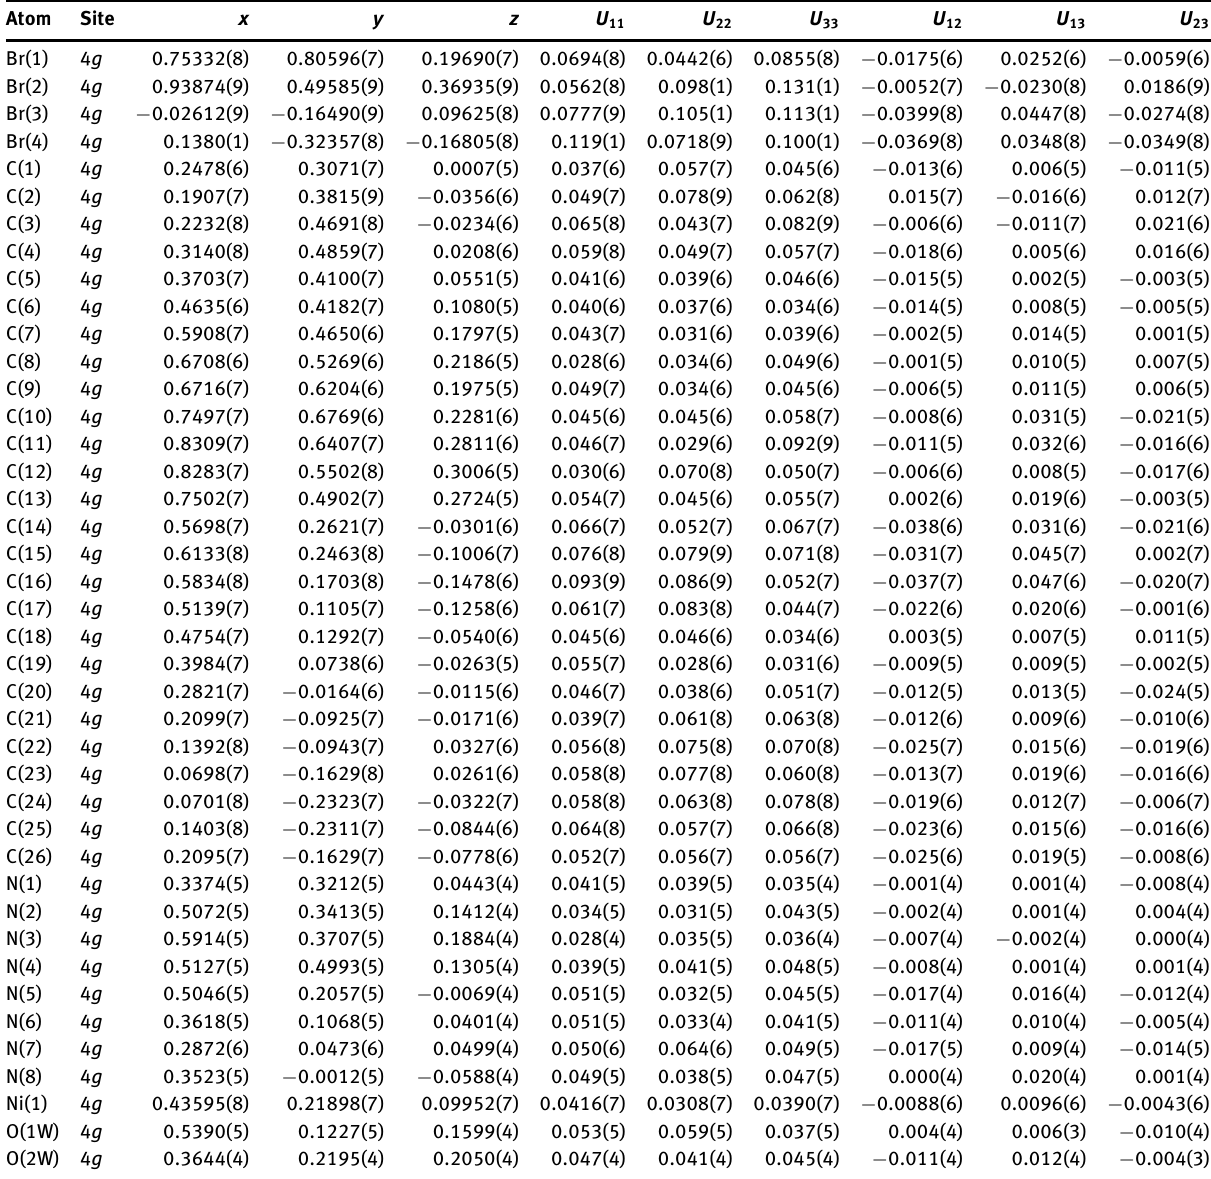
Table 3: Fractional coordinates and atomic displacement parameters (Å 2